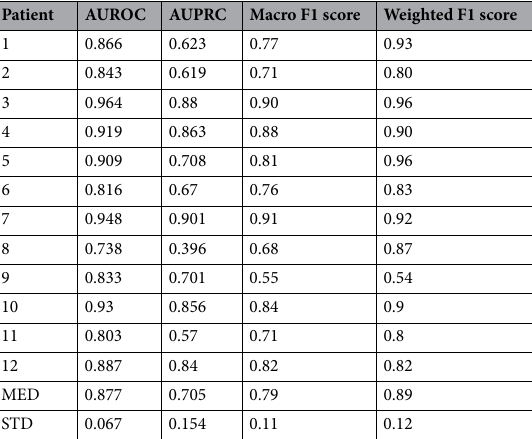
Table 6. The table shows AUROC, AUPRC, and F1 results for the IED detection in pseudo-prospective testing of the proposed method.